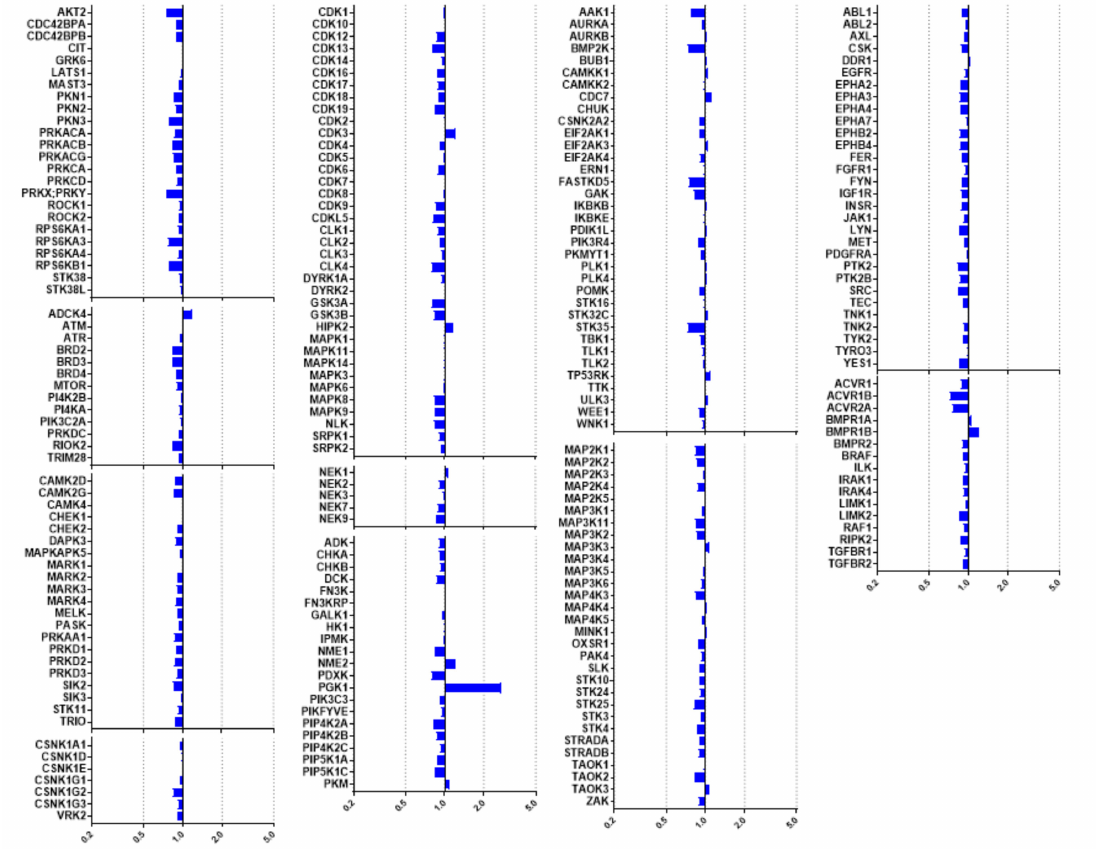
Figure 5. MIBS kinome profiling for thiadiazinone 26 (1 µ M)/DMSO.